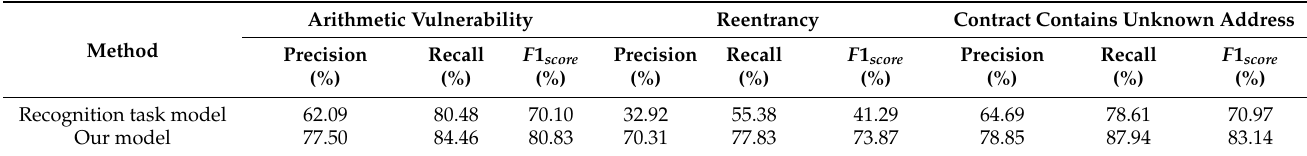
Table 11. Comparison of experimental results between the identification task model and our model.